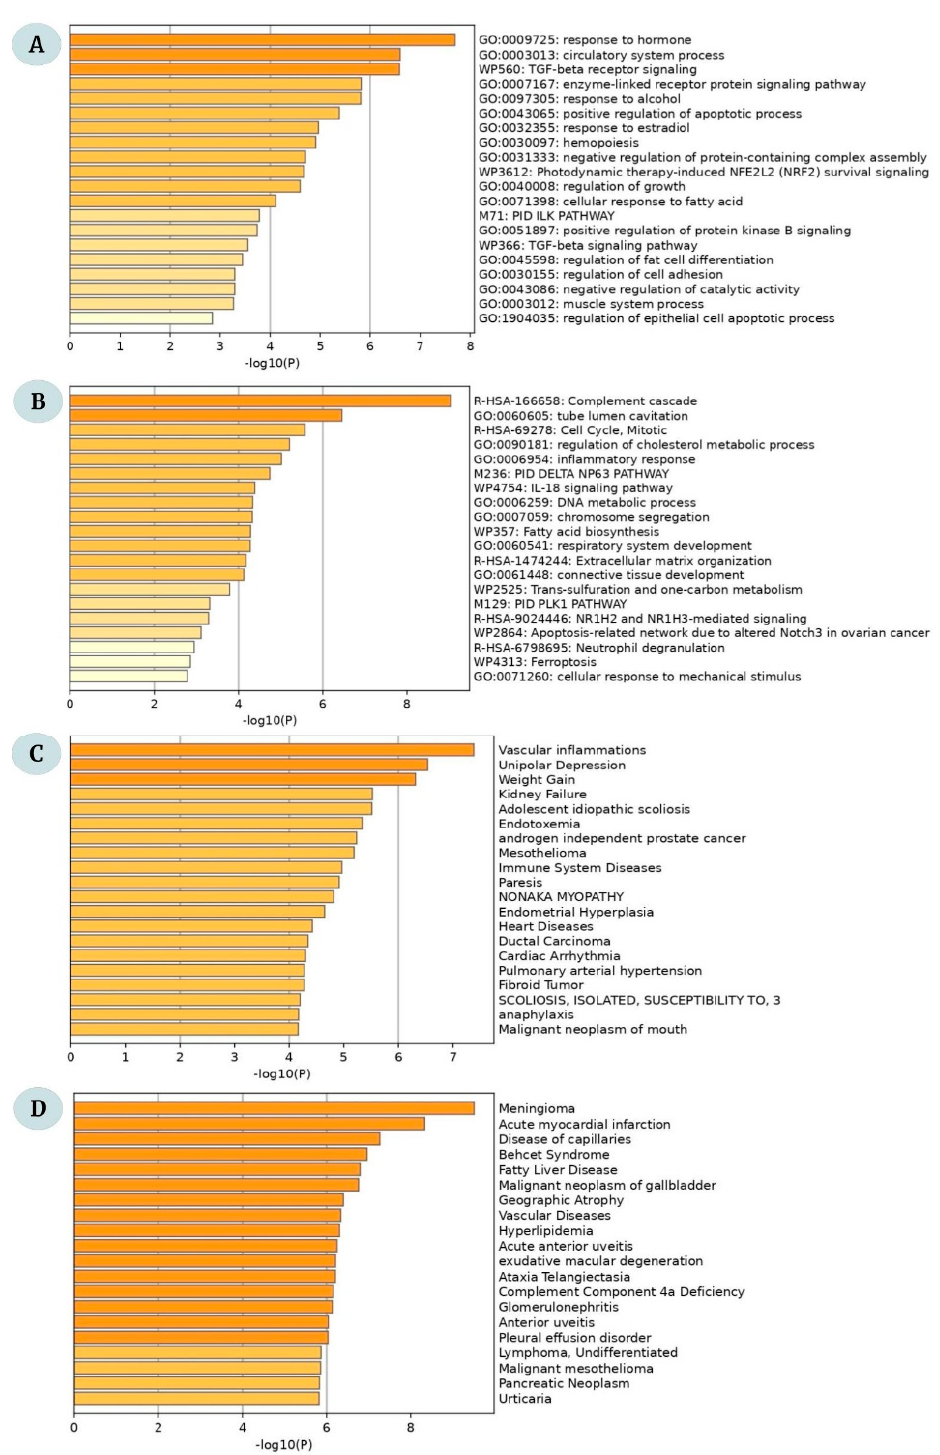
Figure 3. The GO enrichment analysis of the overlapping DEGs between obese and lean children. Top 20 significant enrichment terms for ( A ) upregulated and ( B ) downregulated DEGs. ( C , D ) The top 20 disease-gene interactions for the overlapping genes between obese and lean